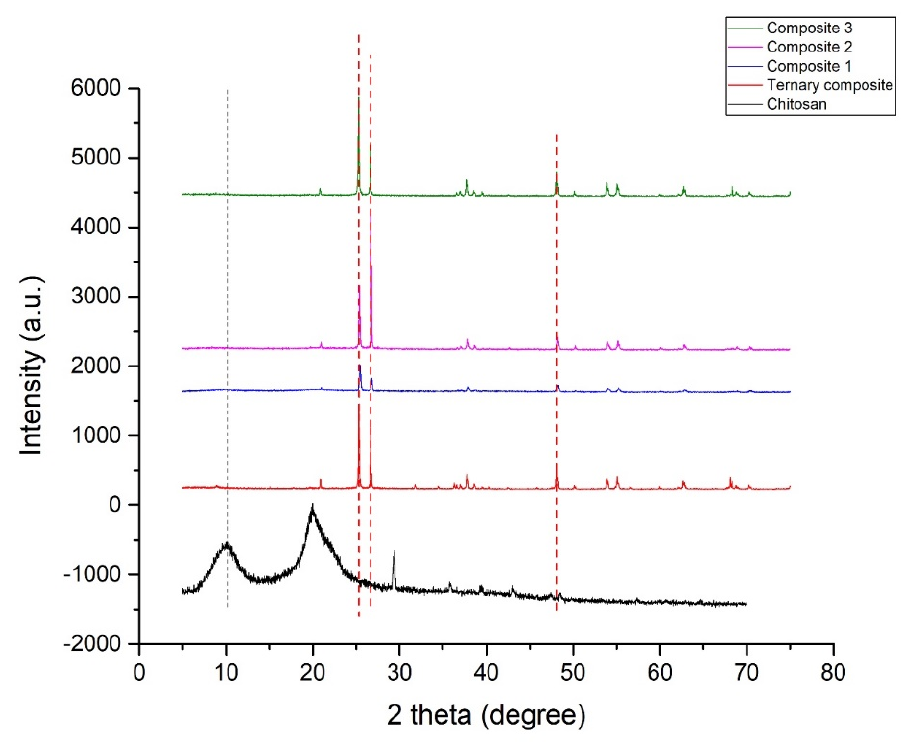
Figure 5. XRD patterns for chitosan, ternary nanocomposite, and nanohybrids (composite 1, composite 2, and composite 3).